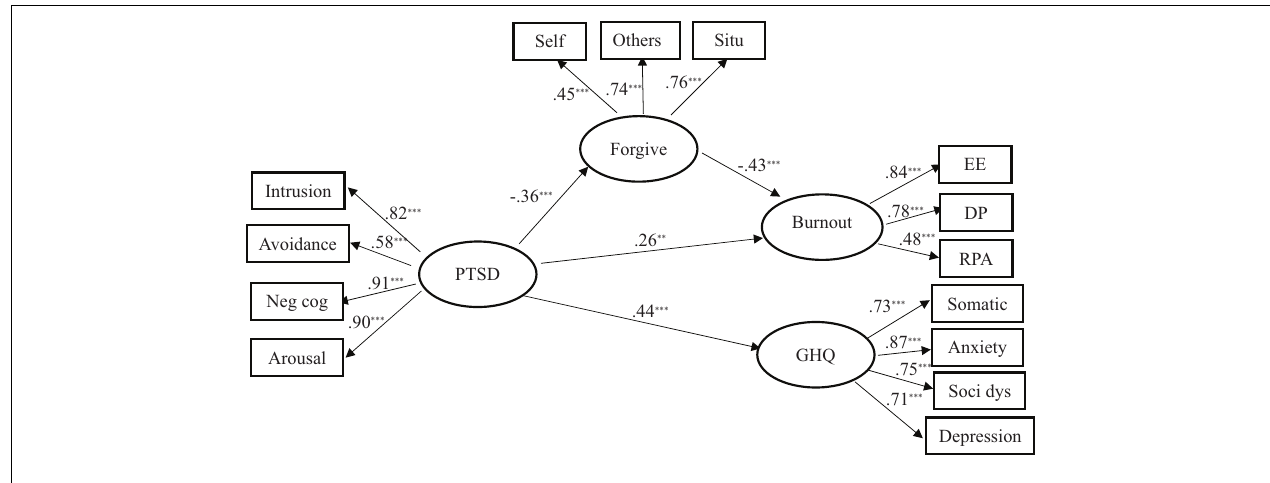
FIGURE 2 | Significant standardized results of regression weights and factor loadings.